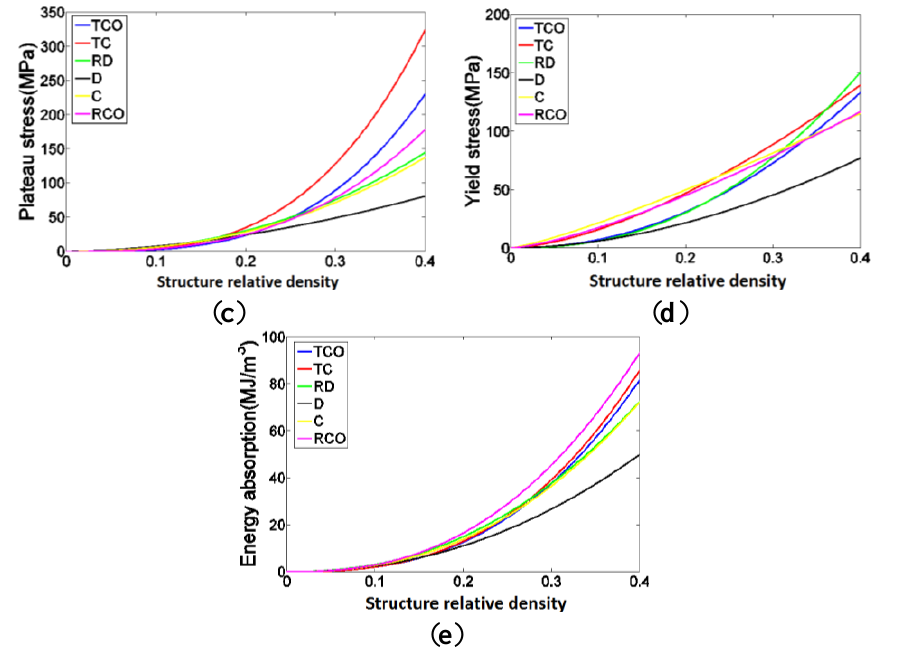
Figure 14. Comparison between the mechanical properties measured for different types of porous structures based on the six different unit cells studied here including ( a ) Elastic gradient; ( b ) First maximum stress. ( c ) Plateau stress; ( d ) Yield stress; ( e ) Energy absorption. In these figures, the power laws fitted to the experimental data points, and not the experimental data points themselves, are compared with each other.